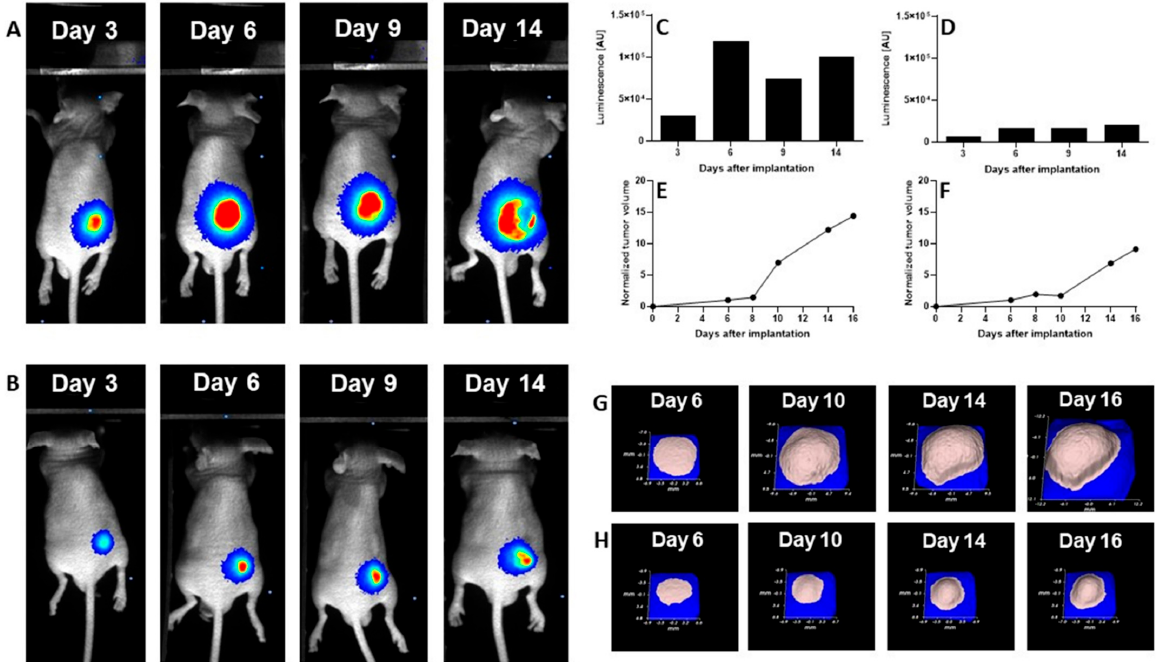
Figure 12. ( A ) The luminescence images of a representative control mouse, while ( B ) shows the luminescence images of a representative mouse receiving OAO–morpholide. ( C , D ) Luminescence measured in regions of interest (ROI) in mice re ‐ ceiving: vehicle and OAO–morpholide. ( E , F ) Tumor volume changes (expressed as a normalized tumor volume) in repre ‐ sentative control and OAO–morpholide ‐ treated mice, respectively, while ( G , H) shows corresponding pictures